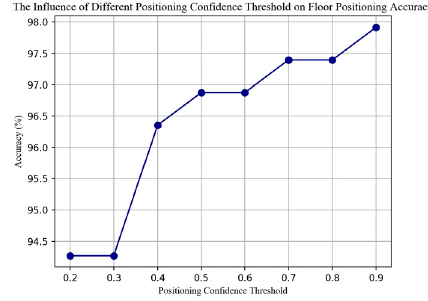
Figure 10. The influence of different floor positioning confidence threshold on the floor positioning accuracy.